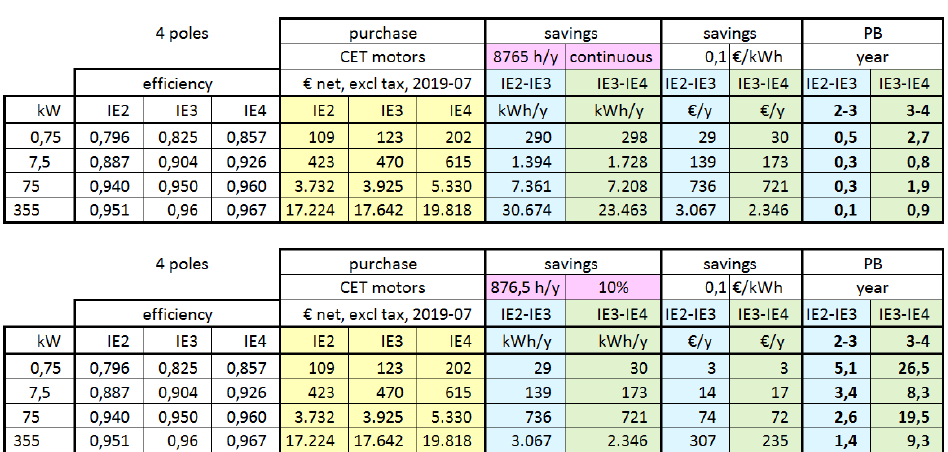
Fig. 14. – Payback time as a function of the efficiency class, estimation for different